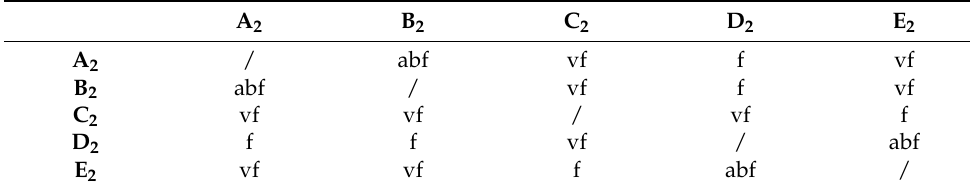
Based on the spatial relations computed by the corresponding operations, the topological, direction, and distance relation similarities between (a) and (b) are S Top = (0.75 × 1 + 1 × 9)/10 = 0.975, S Dir = (1 × 10)/10 = 1.0, and S Dis = ((1 − 0.255/0.806) × 2 + (1 − 0.158/0.806) + 7 ×